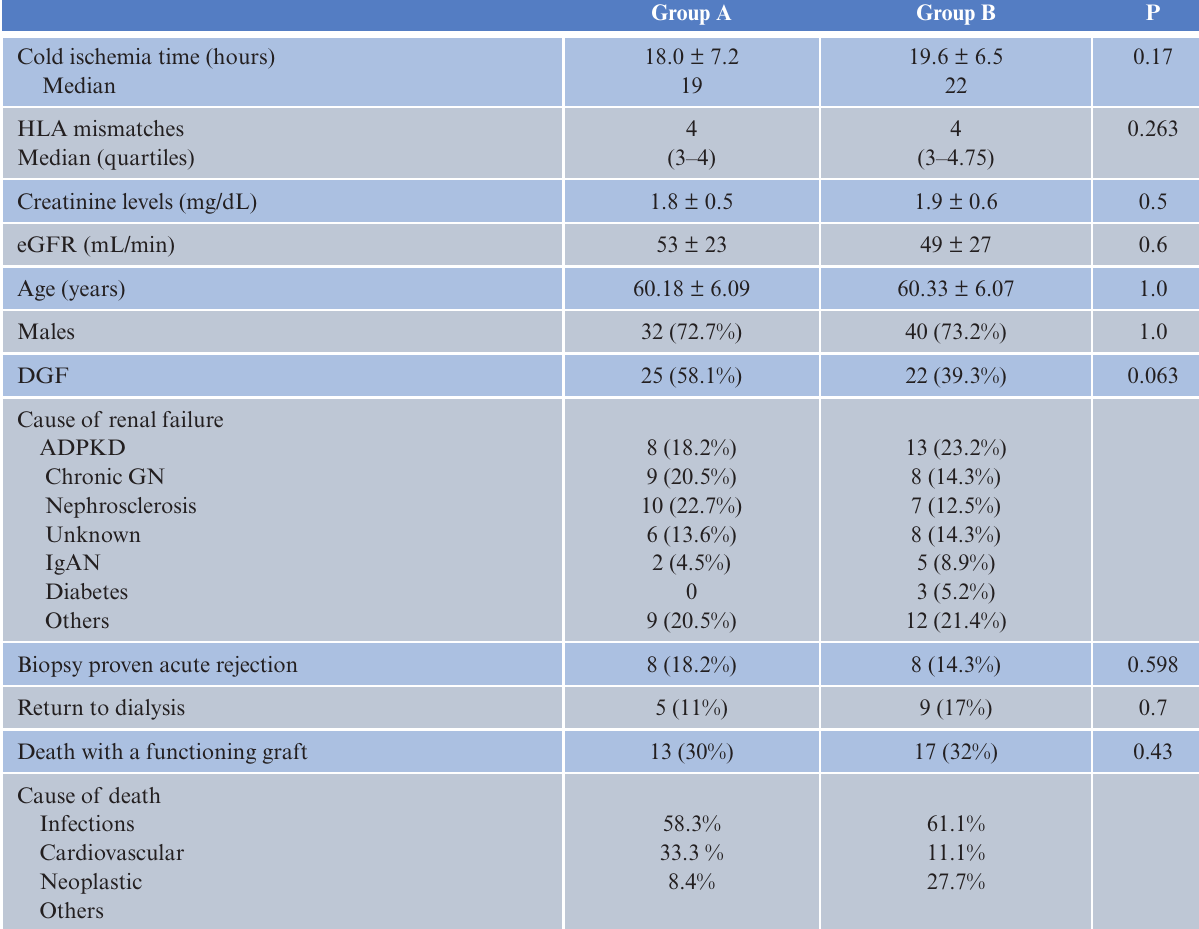
Table 2: Recipients’ characteristics and results 5 years after